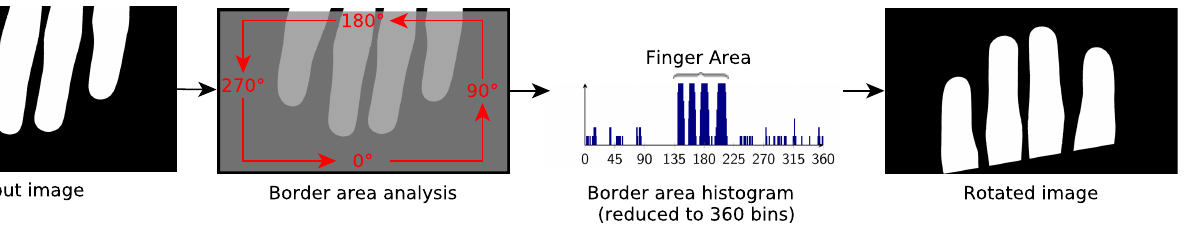
Figure 3. Overview of the coarse rotation correction, separation of fingerprint images from each other, fine rotation correction, fingertip cropping, and normalization of the fingerprint size.